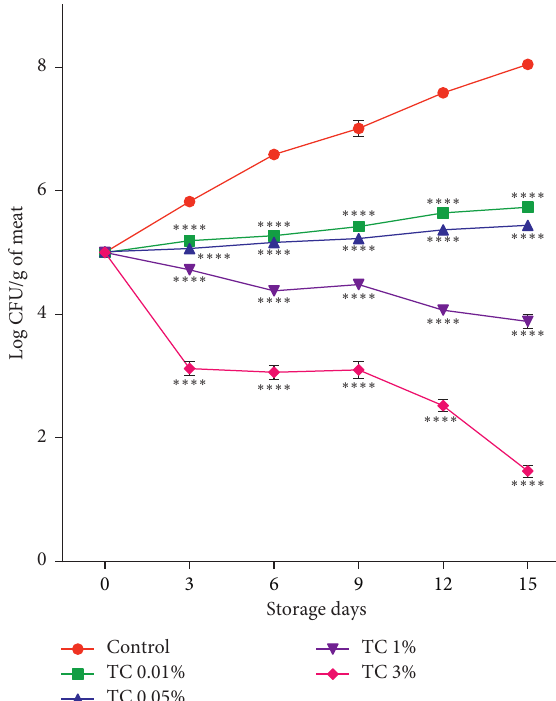
Figure 2: Time-related survival, at 4 ° C, of the low meat con- tamination level (10 5 CFU/g) of P. aeruginosa , following treatment with increasing concentrations of T. capitatus EO. The results represent the means of three replicate experiments, and error bars represent the standard error of the mean. Statistical significance differences: ∗ p < 0 . 05 (significant), ∗∗ p < 0 . 01 (very significant), and ∗∗∗ p < 0 . 001 and ∗∗∗∗ p < 0 . 0001 (extremely significant). CFU: colony-forming unit; TC: Thymus capitatus